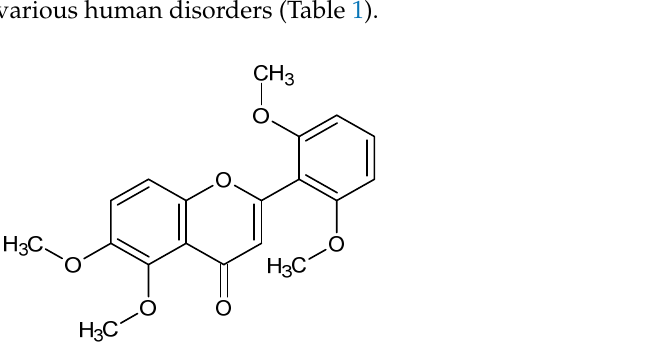
Figure 1. Chemical structure of zapotin.